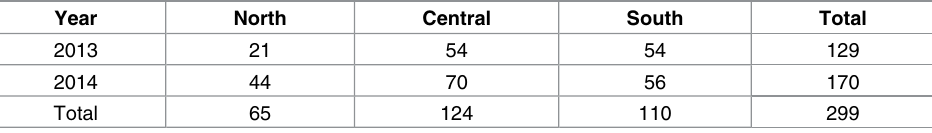
Table 1. Number of video surveys